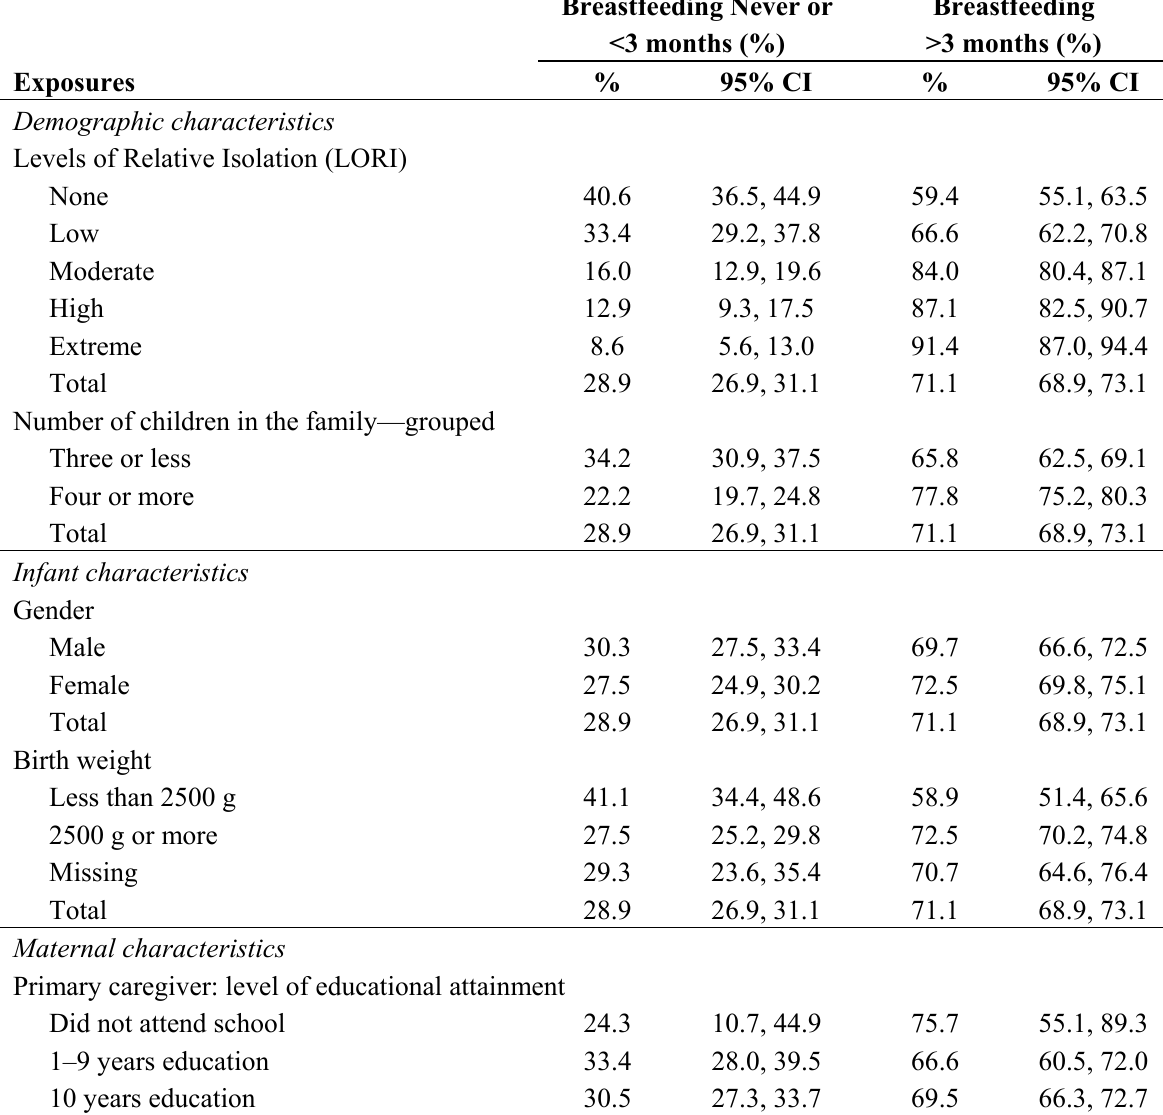
Table 2. Bivariate analysis: Comparison of breastfeeding duration to demographic, maternal and infant characteristics of Western Australian Aboriginal children aged 0–17, whose primary caregiver is their birth mother